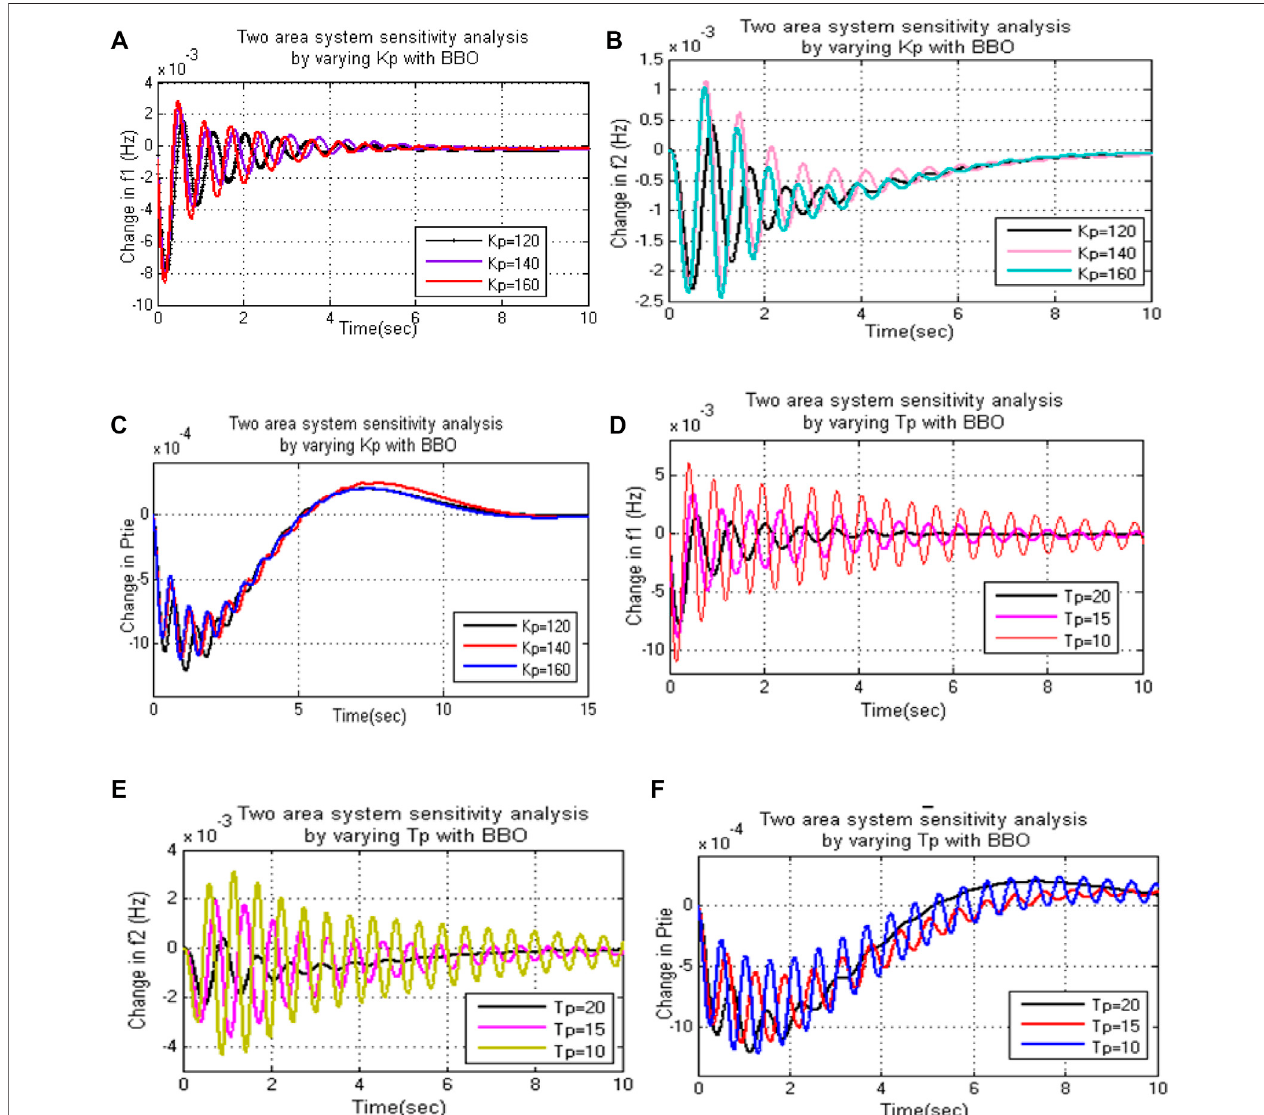
FIGURE 4 | Sensitivity analysis in the presence of HVDC link. (A) Effect of variation ofKp on f 1 . (B) Effect of variation of Kp on f 2 . (C) Effect of variation of Kp on P tie . (D) Effect of variation of Tp on f 1 . (E) Effect of variation of Tp on f 2 . (F) Effect of variation of Tp on P tie .